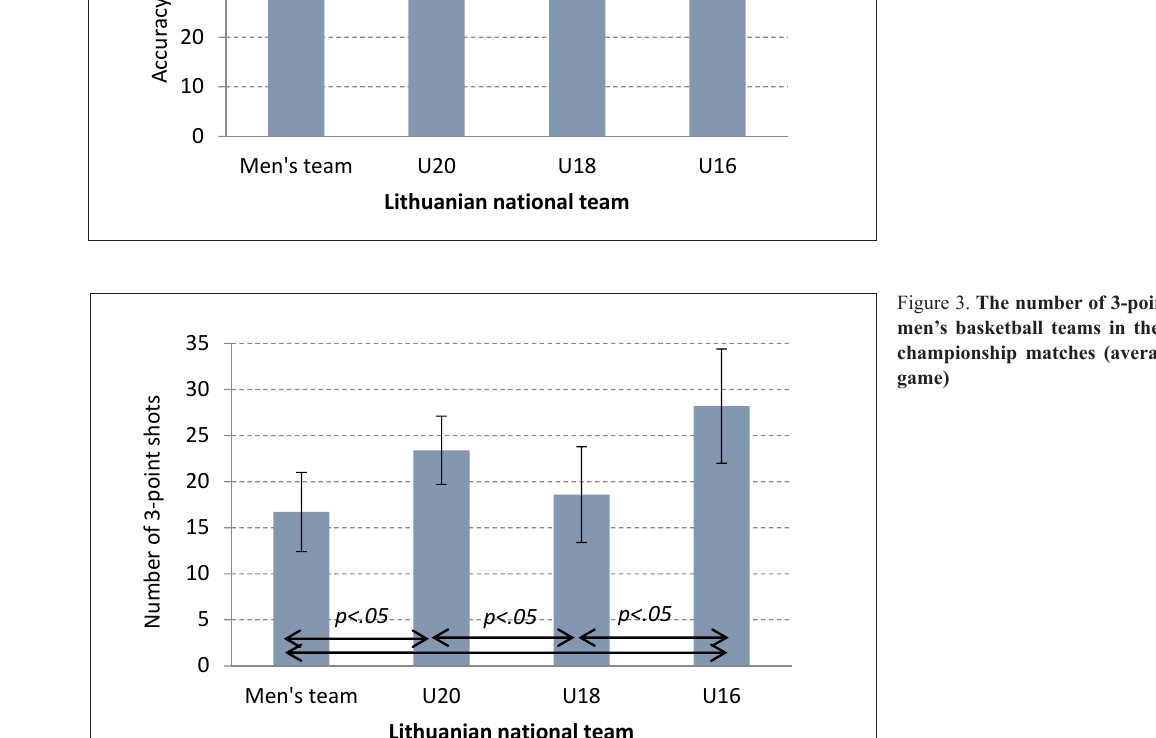
Figure 1. The number of 2-point shots for men’s basketball teams in the European championship matches (average per one game)